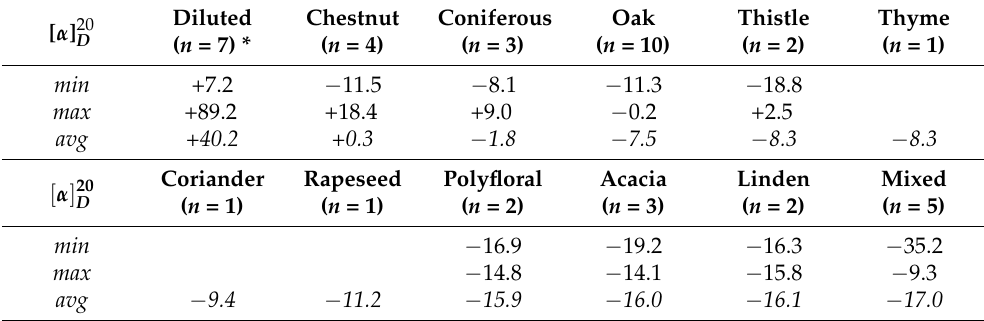
Table 1. Minimum (min), maximum (max) and average (avg) specific angle values of honey of different botanical origin, including adulterated (diluted)